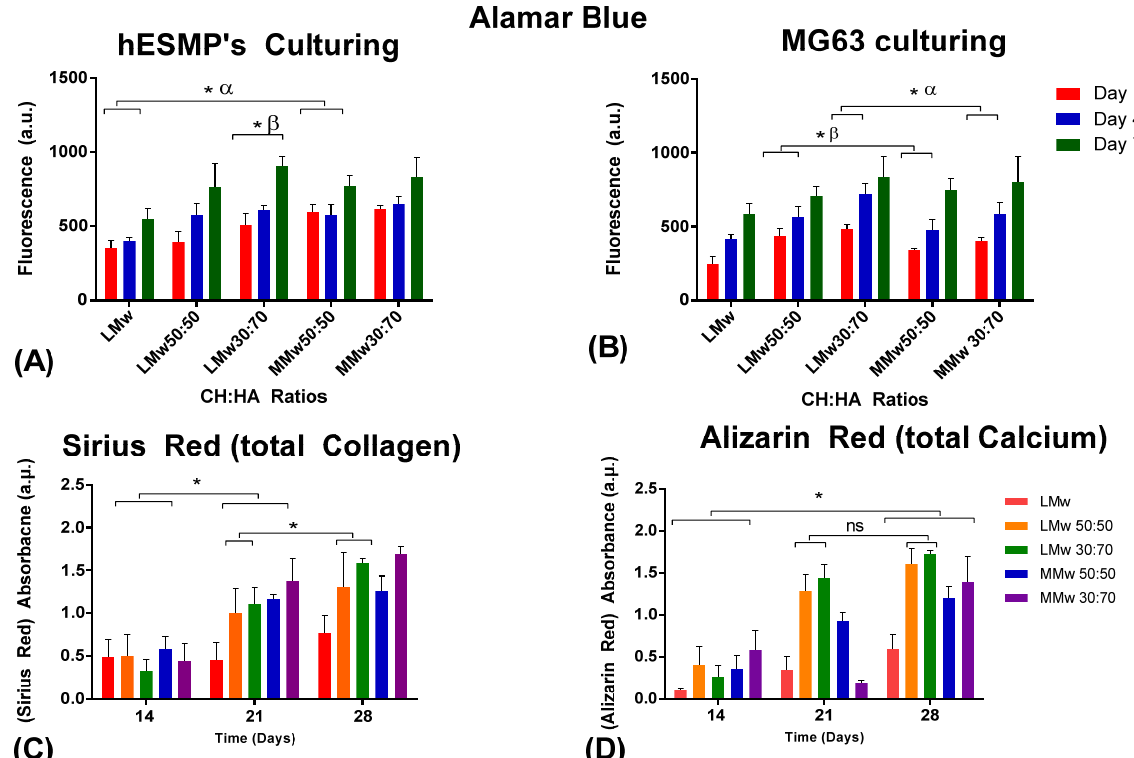
Figure 7. Cytotoxicity conducted via culturing ( A ) hES-MP and ( B) MG63s. Cellular viability analysed with Alamar blue staining until day 7. Values shown are taken from mean ± SD where n = 3. ( C ) Collagen and ( D ) calcium accumulated by hES-MPs at day 14, 21 and 28. (ns, no statistically significant difference, α and β represent statistically significant difference in between the observed groups). (*) indicates statistically significant